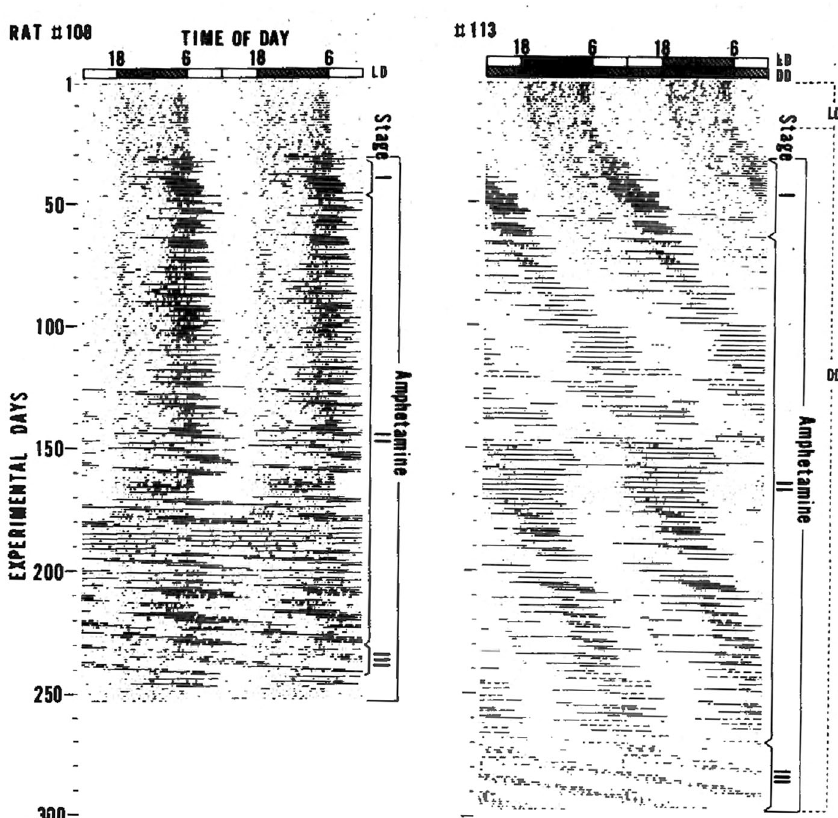
Figure 1. Locomotor activity rhythms in rats are altered by d-amphetamine administered in drinking water. Figure reproduced from Ikeda and Chiba 1982 7 with permission of